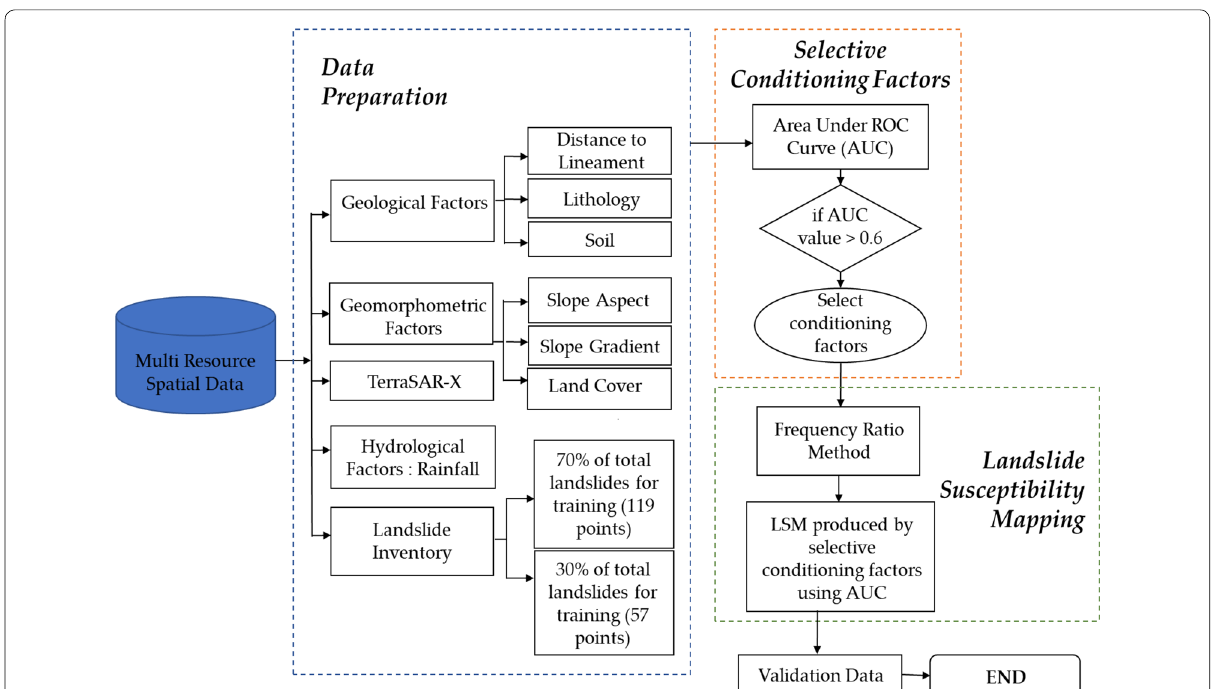
Fig. 3 Flowchart of a research